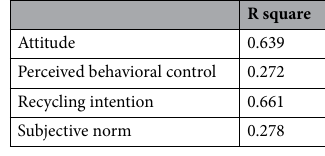
Table 5. R 2 for the endogenous variable.